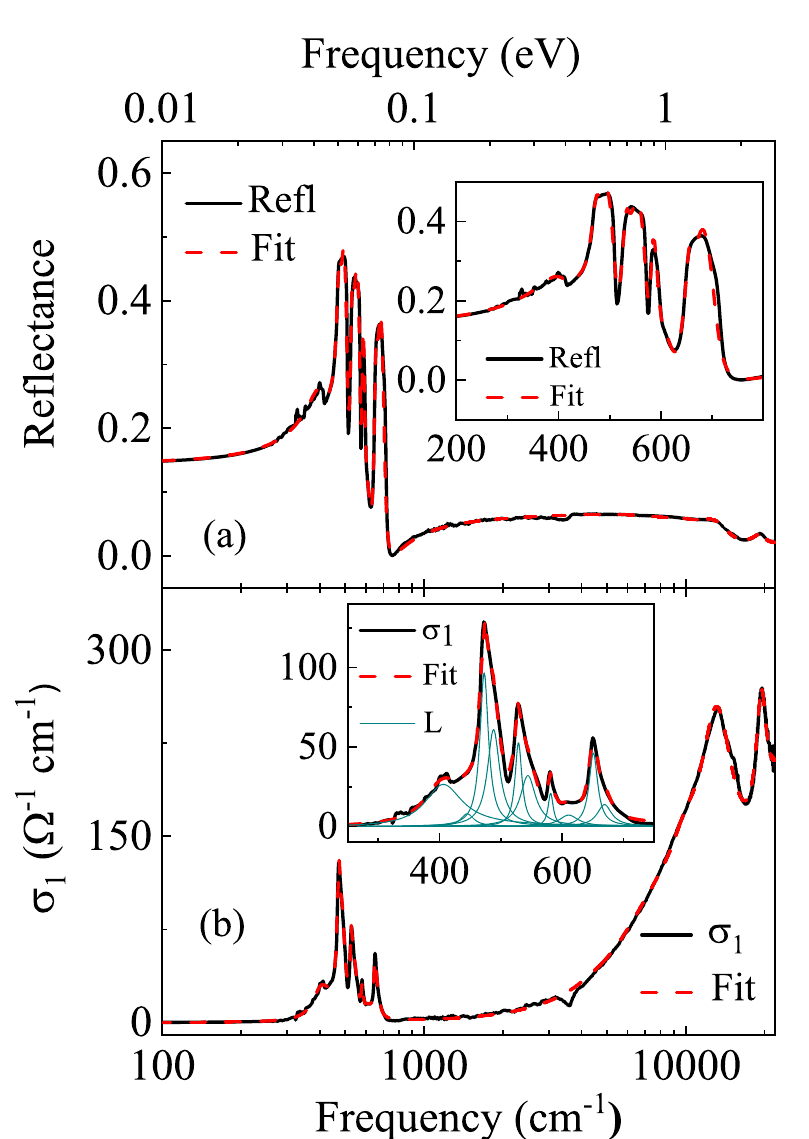
Figure 4. Ambient pressure ( a ) reflectance and ( b ) optical conductivity spectrum of LiInCr 4 O 8 in the range 100–22,000 cm − 1 , together with the Lorentz fitting. The insets of ( a , b ) depict the corresponding low-frequency range (200–800 cm − 1 ) of the reflectance and optical conductivity spectrum, respectively, where the phonon modes are located, together with the Lorentz